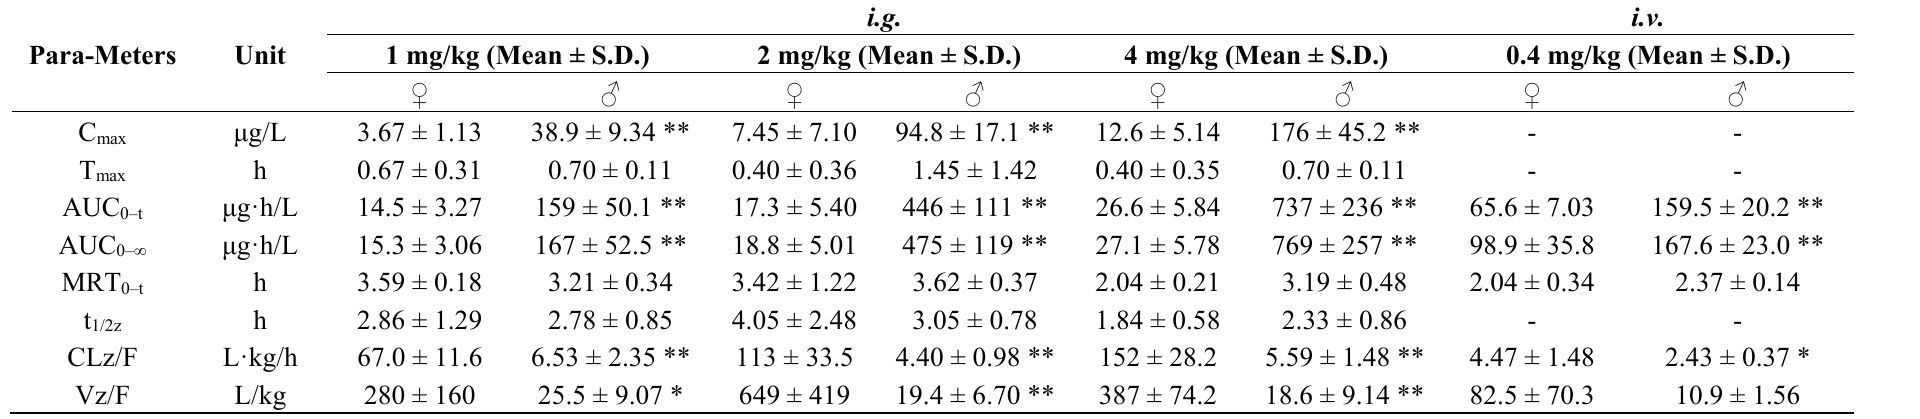
Table 1. Pharmacokinetic parameters of verticinone after i.g. and i.v. administration to SD rats (n =